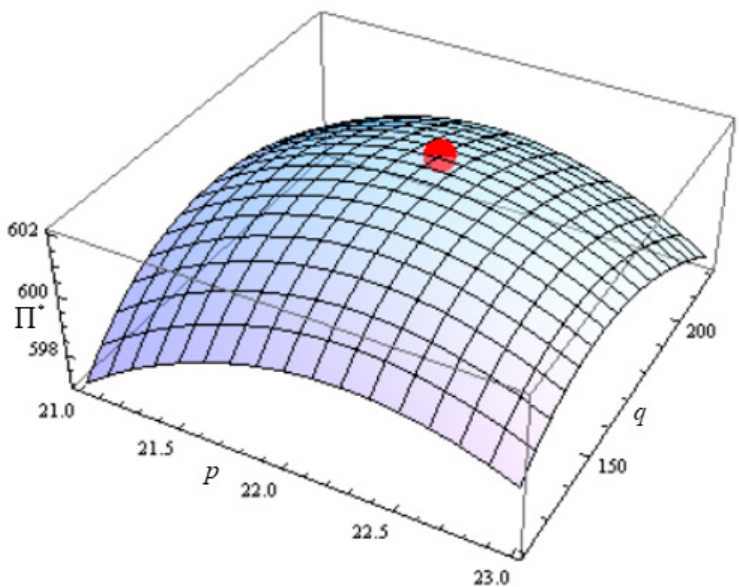
Figure 3. Concavity of ∏ ∗ with respect to p and q at ζ = 2, η = 1, ρ = 1, I = 1.68236 and T = 1. Table 4. The results.